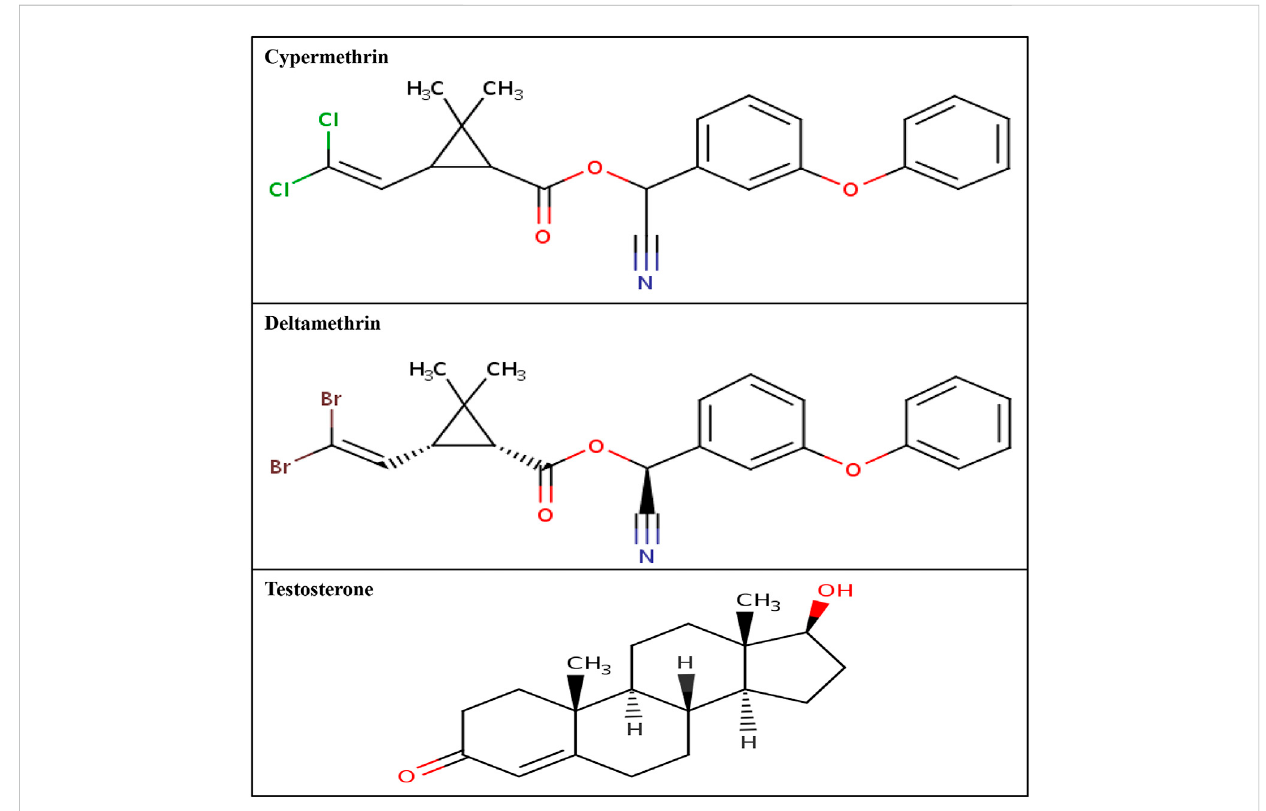
FIGURE 3 Two-dimensional structure of cypermethrin, deltamethrin, and AR native ligand, testosterone.